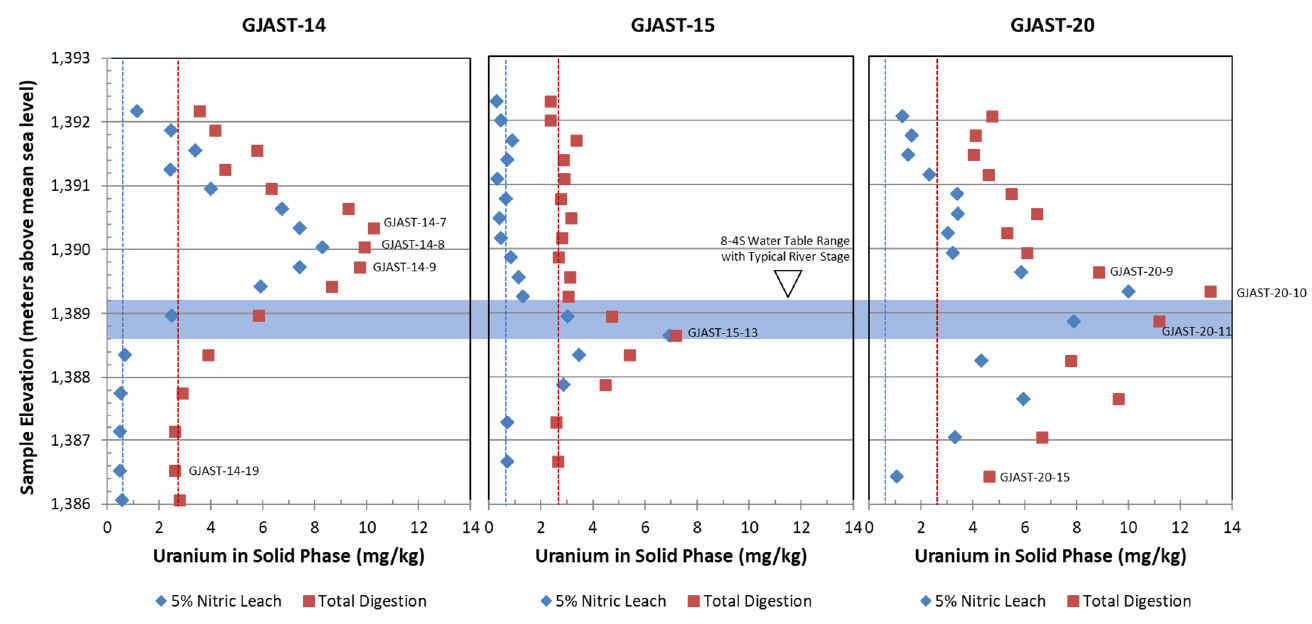
Figure 2. GJAST-14, 15, and 20 (locations in Figure 1) uranium concentrations with depth (National Geodetic Vertical Datum of 1929) for total digestion and 5% nitric acid extraction. Background values from GJAST-03 are 0.62 mg/kg for 5% nitric acid extraction (dashed blue vertical line) and 2.7 mg/kg for total digestion (dashed red vertical line). Individual identification labels indicate samples with fission-track radiography, thin section plain light microscopy, and SEM-EDS analyses. The first sample for all three locations is always 0.3 m (1 foot) below ground surface. The water level during typical stream flow conditions in nearby well 8-4S (Figure 1) is indicated as a range by the wide blue horizontal line, which does not include times when this well is influenced by high river stage and the water table rises substantially.